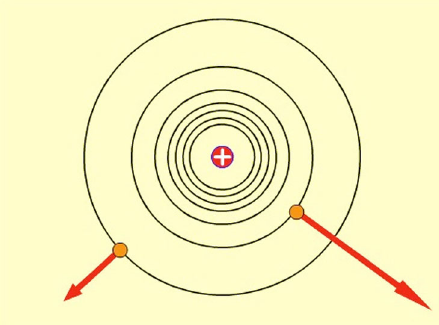
instruction.FIG. 2. The equipotential lines for a positive point charge, drawn at intervals of every 5 V. The diagram shows the correspondence between equipotential lines and electric field by showing the direction and magnitude of the electric field at two points (Image taken from the Charges and Fields PhET simulation